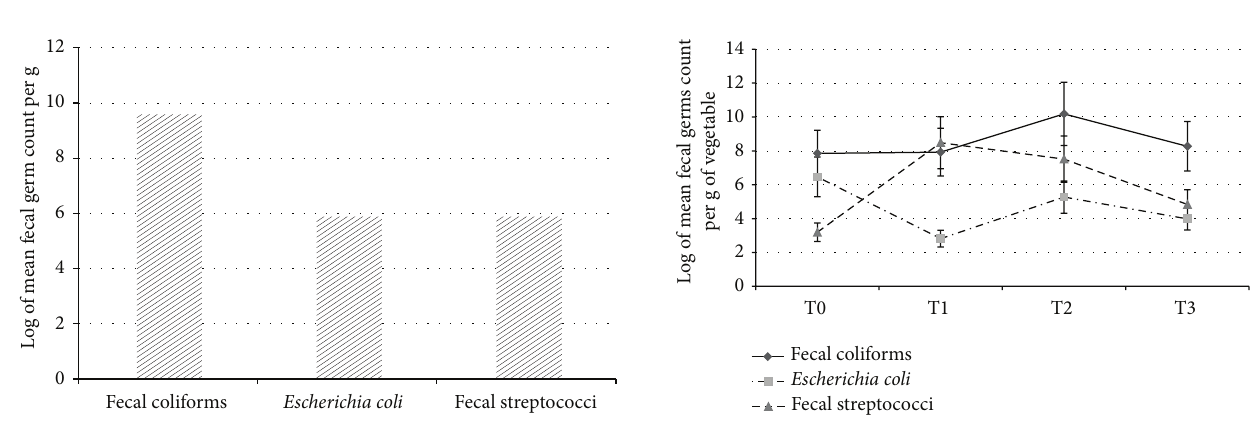
Figure 3: Populations of fecal coliforms, Escherichia coli , and fecal streptococci on vegetables (sites, growing periods, fertilization treatments and vegetables considered together (coastal area of Benin, 2009-2010, 288 plots, 96 samples)).